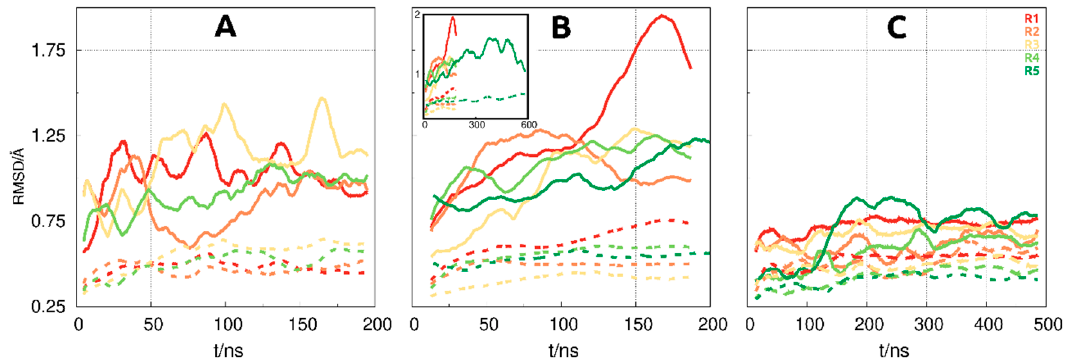
Figure 2. Root mean square deviation (RMSD) plots of the five molecular dynamics (MD) simulation runs (R1–R5) for HER2 ( A ), F0178:HER2 ( B ), and ScFv:HER2 ( C ). Full lines depict calculations made with all four ECD regions, whereas dotted lines do not include ECDIV. The small inset in ( B ) shows the full length of the longer production run (R5).